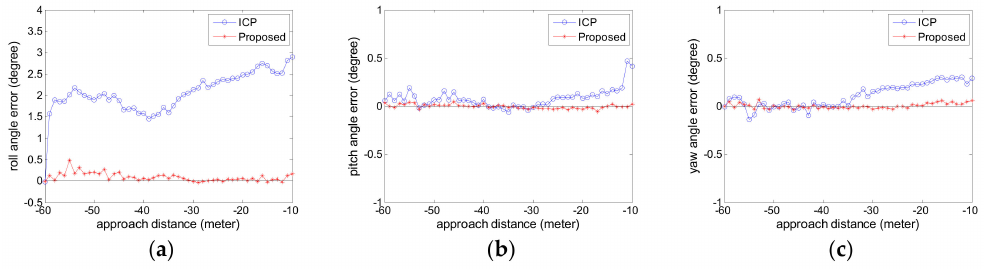
Figure 10. The attitude error curve in Experiment 2 ( a ) roll angle error; ( b ) pitch angle error; ( c ) yaw angle